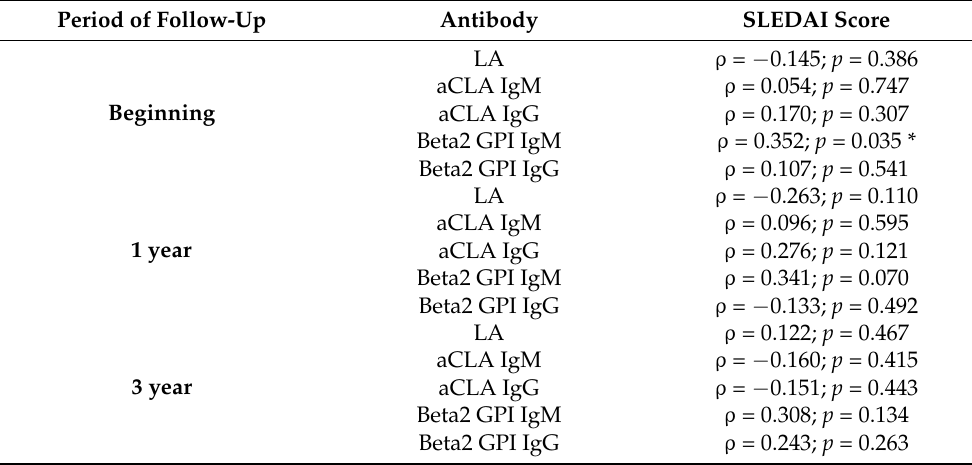
Table 4. Correlation of aPLA with SLEDAI score during three-year